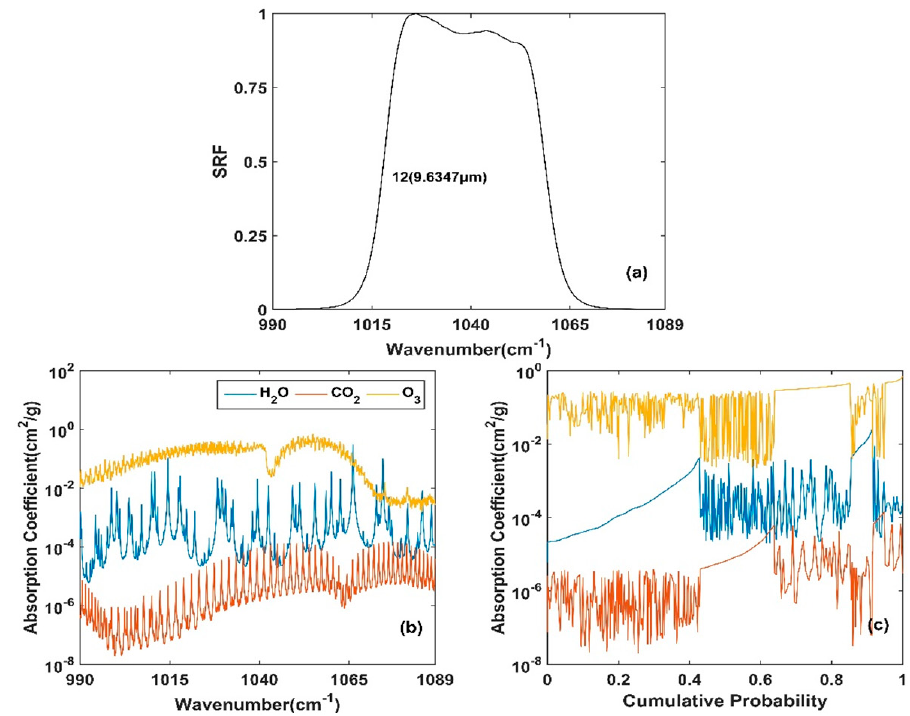
Figure 1. The application of AMCKD to 9.6347 µ m channel of AHI. ( a ) The instrument SRF of AHI at the 9.6347 µ m channel. ( b ) Gaseous absorption coe ffi cients of H 2 O, CO 2 , and O 3 , as the function of wavenumber. ( c ) Absorption coe ffi cients in CPS with SRF after sorted by AMCKD.